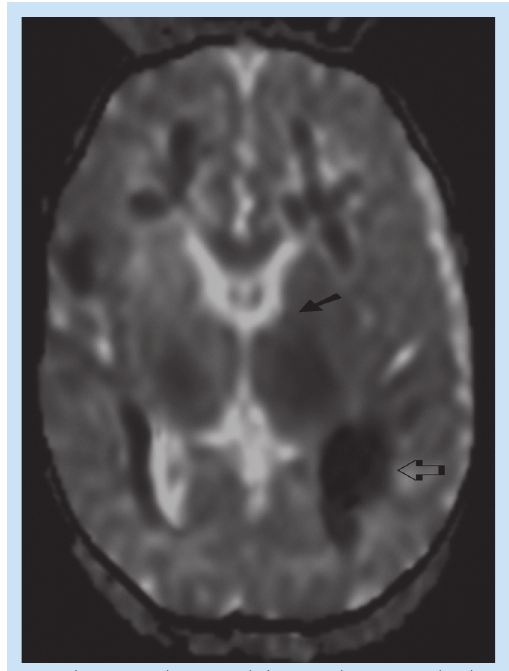
Fig. 2.1b. ADC map shows reversal of DWI signal in periventricular white matter indicating restricted diffusion (hypoxia and cytotoxic oedema). The parenchymal and ventricular blood remains dark and is termed diffusion